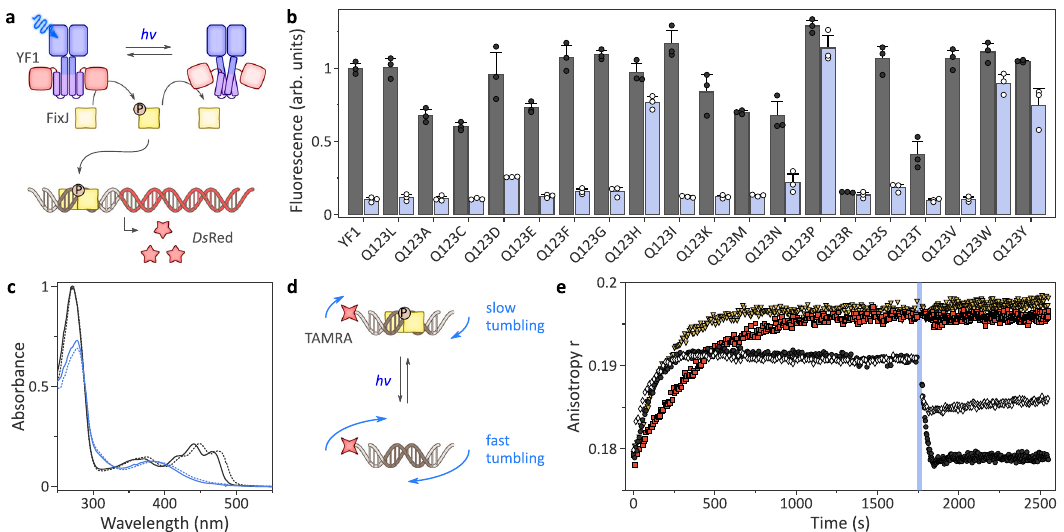
Fig. 2 Activity and light response of YF1 variants. a The net kinase activity of the variants was assessed in the pDusk- Ds Red setup 31 , where alongside the response regulator Bj FixJ, YF1 drives the expression of the red- fl uorescent reporter Ds Red in blue-light-repressed manner. b Normalized Ds Red fl uorescence of E. coli cultures harboring pDusk plasmids encoding different YF1 variants. Cells were cultivated in darkness (black dots and gray bars) or under constant blue light (white dots and blue bars). Data represent mean ± s.d. of three biologically independent replicates. c Absorbance spectra of YF1 Q123L (solid lines) in its dark-adapted (black) and light-adapted states (blue), compared to the corresponding spectra of YF1 (dotted lines). d Schematic of the coupled fl uorescence anisotropy assay to probe YF1 activity. Once phosphorylated in light-dependent manner (see a ), Bj FixJ homodimerizes and binds to its cognate DNA operator sequence. Said operator is embedded in a TAMRA-labeled double-stranded DNA molecule, and Bj FixJ binding can be detected as an increase in fl uorescence anisotropy due to decelerated rotational tumbling. e YF1 (black dots), YF1 Q123L (white diamonds), YF1 Q123H (yellow triangles), or YF1 Q123P (red squares) were incubated in darkness together with Bj FixJ and the TAMRA-labeled DNA. At time zero, the reaction was initiated by ATP addition and fl uorescence anisotropy was recorded for 30 min. Samples were then illuminated for 30 s with blue light (blue bar), and the measurement continued. All experiments were repeated at least twice with similar